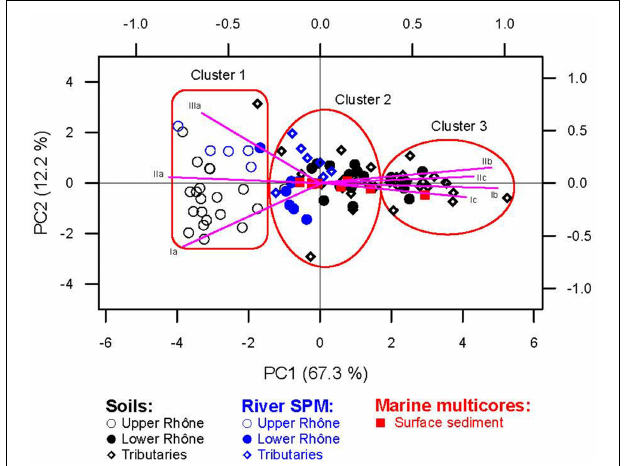
FIGURE 7 | Results of the Principal Component Analysis (PCA) for CL brGDGTs of the soils, the river SPM, and the marine surface sediments. The first two PCs explain 79.5% of the variation in the data. Symbols and purple lines represent scores and response variables (brGDGTs), respectively. Note that GDGT IIIb and IIIc were not included in the analysis due to the detection limit. Three clusters resulting from a Hierarchical Clustering on Principal Components (HCPC) were highlighted as red